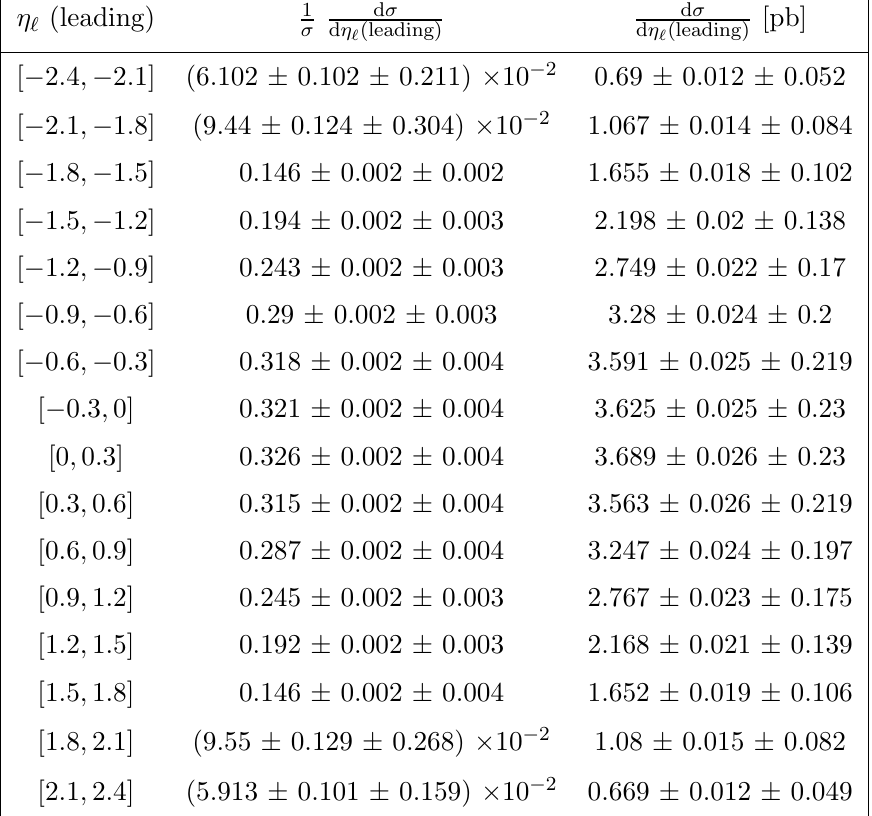
Table 35 . The measured di(cid:11)erential cross section and bin boundaries for each bin of the normalized and absolute measurements of the tt di(cid:11)erential cross section at particle level in the (cid:12)ducial phase space as a function of (cid:17) ‘ (leading) are tabulated.